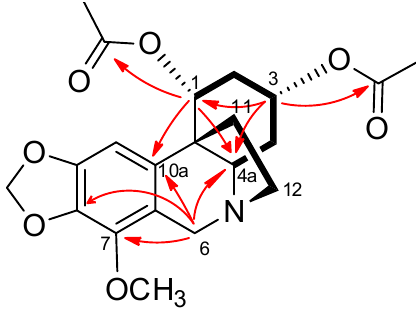
Figure 2. Important COSY ( — ) and HMBC (H → C) correlations of compound 2 .